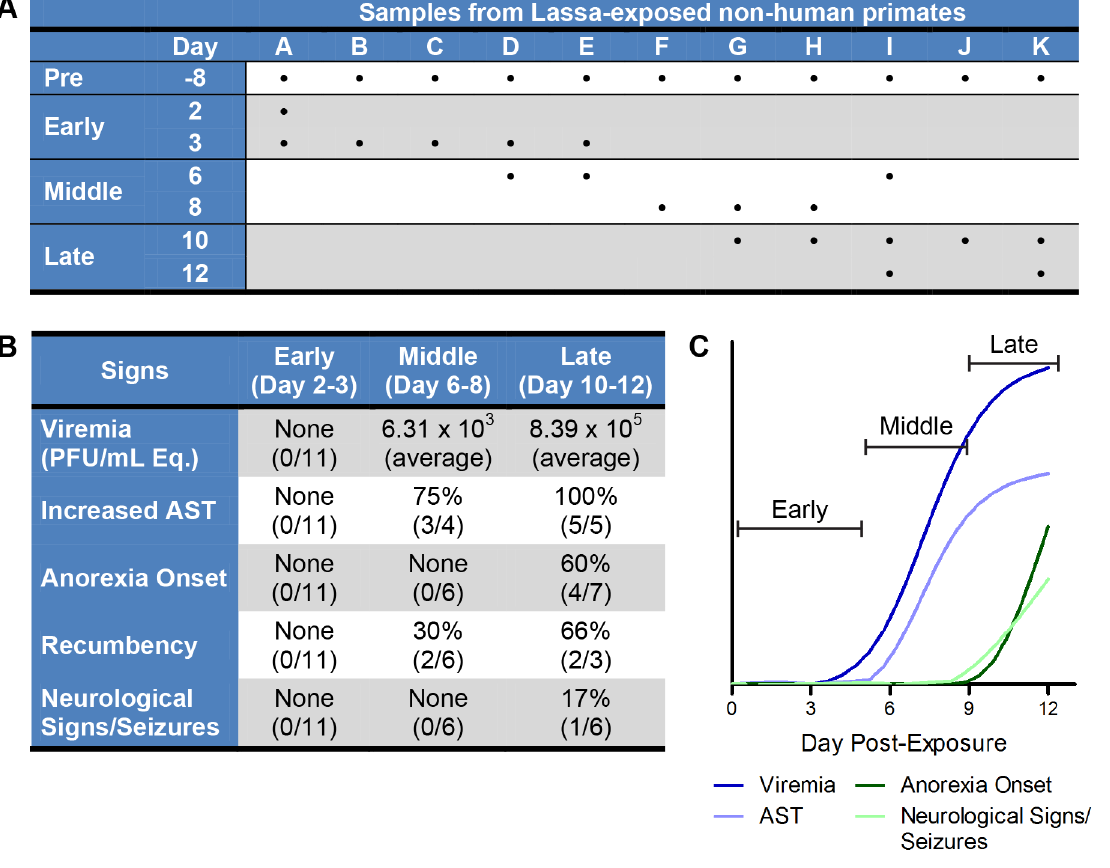
NHPs) were used in the subsequent analyses as shown in Figure 1A. The resulting microarray dataset has been submitted to the Gene Expression Omnibus (GEO) database, under series record GSE41752.